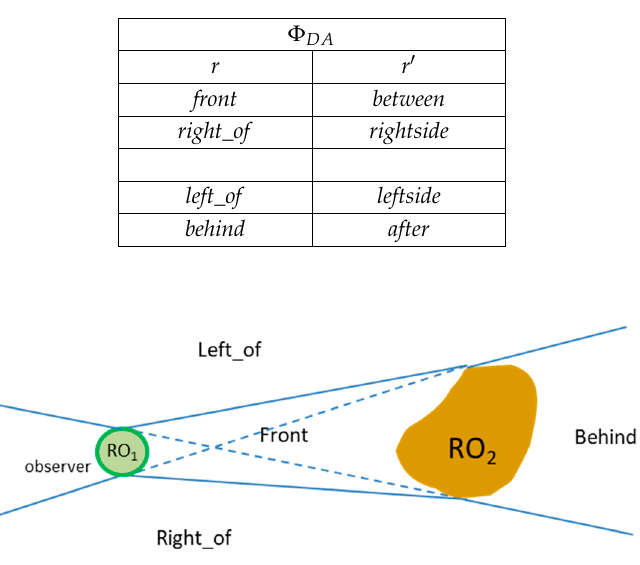
Figure 7. Deictic frame of reference.